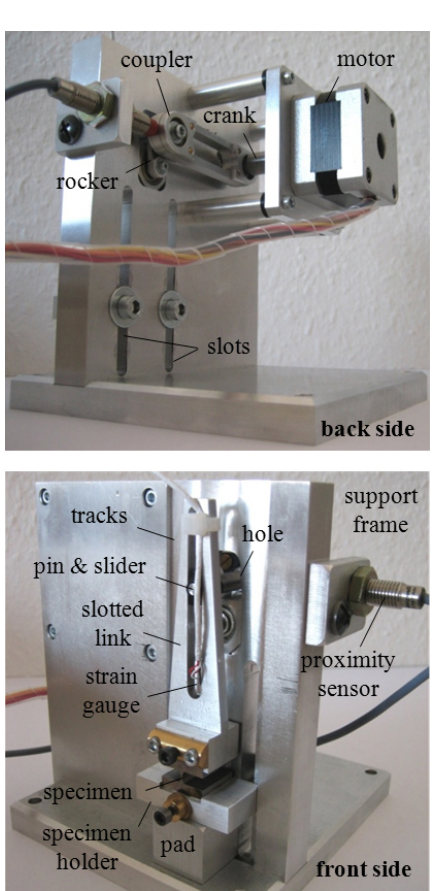
Figure 4. Fatigue test bench designed and realized at the Depart- ment of Mechanism Theory and Dynamics of Machines of RWTH Aachen